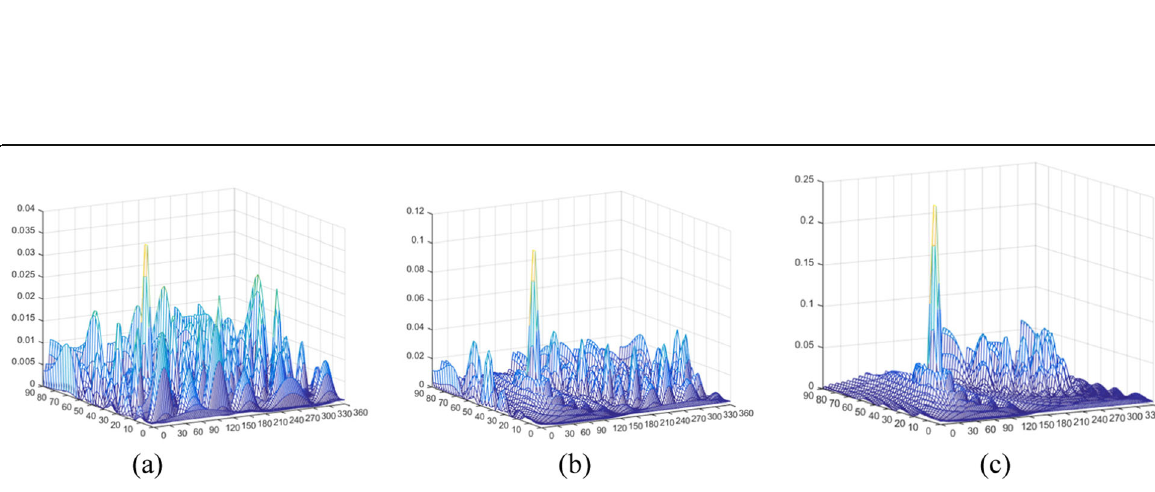
Fig. 6 Peaks of beam patterns towards drone directions. Number of MEs: a 12, b 24, and c